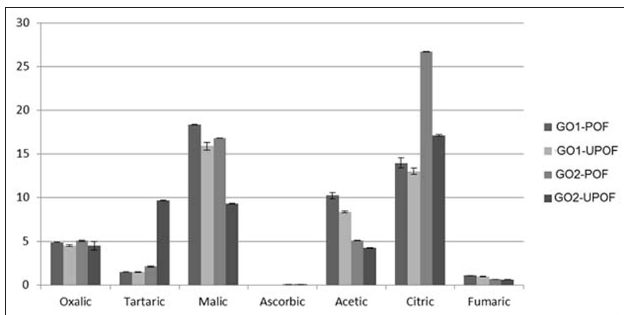
Fig. 3: The organic acids of peeled (POF) and unpeeled (UPOF) oleaster flours from two genotypes (GO1 and GO2). Data show mean values of three replicates +/- standard